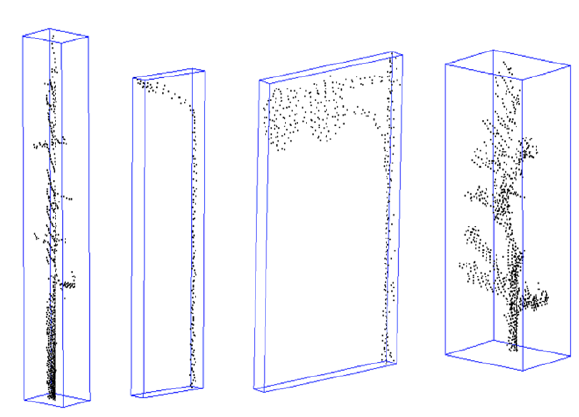
Figure 15. Sizes of bounding